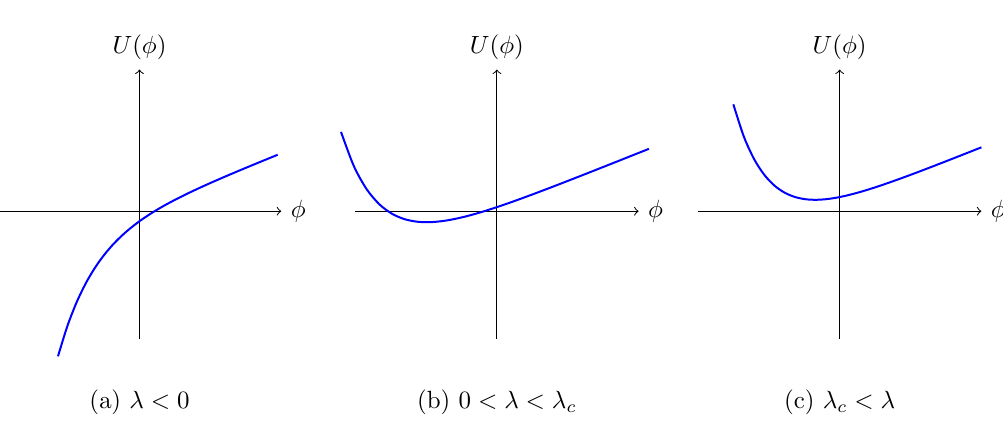
Figure 3 . Shape of the dilaton potential for (a) (cid:21) < 0 with only a single zero at a positive value of (cid:30) (b) 0 < (cid:21) < (cid:21) c with two zeros at negative values and (cid:30) 0 the largest and (c) (cid:21) c < (cid:21) with no